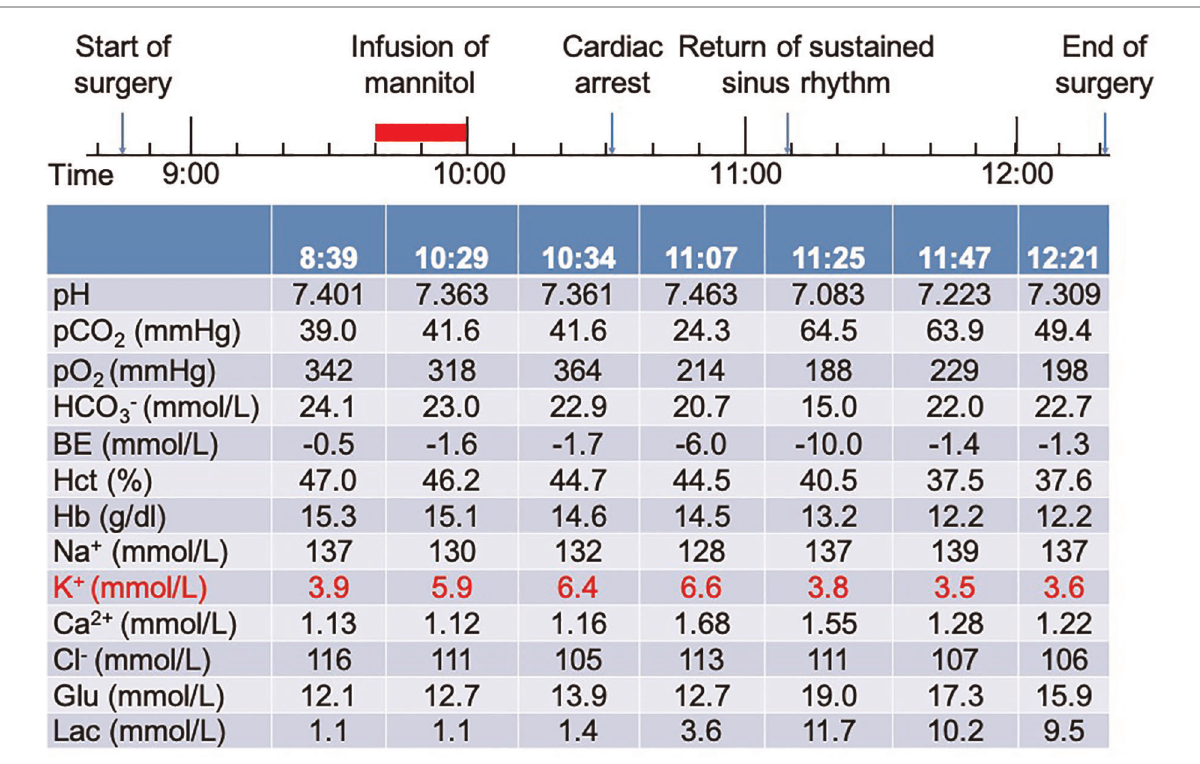
FIGURE 1 Timeline of surgery and results of arterial blood gas analysis of the